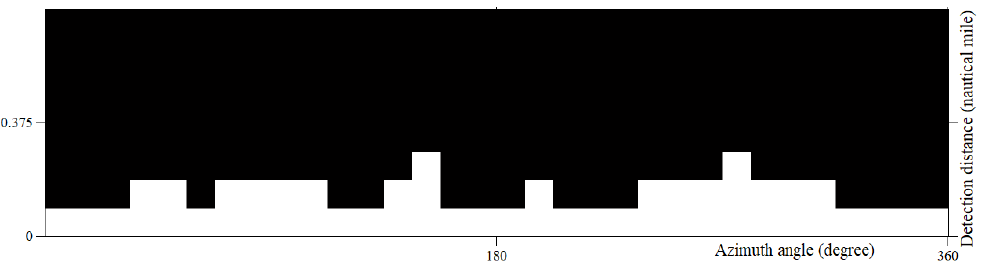
Figure 7. SVM Classification result of effective ocean wave monitoring regions. Some remote misclassification regions had been deleted.